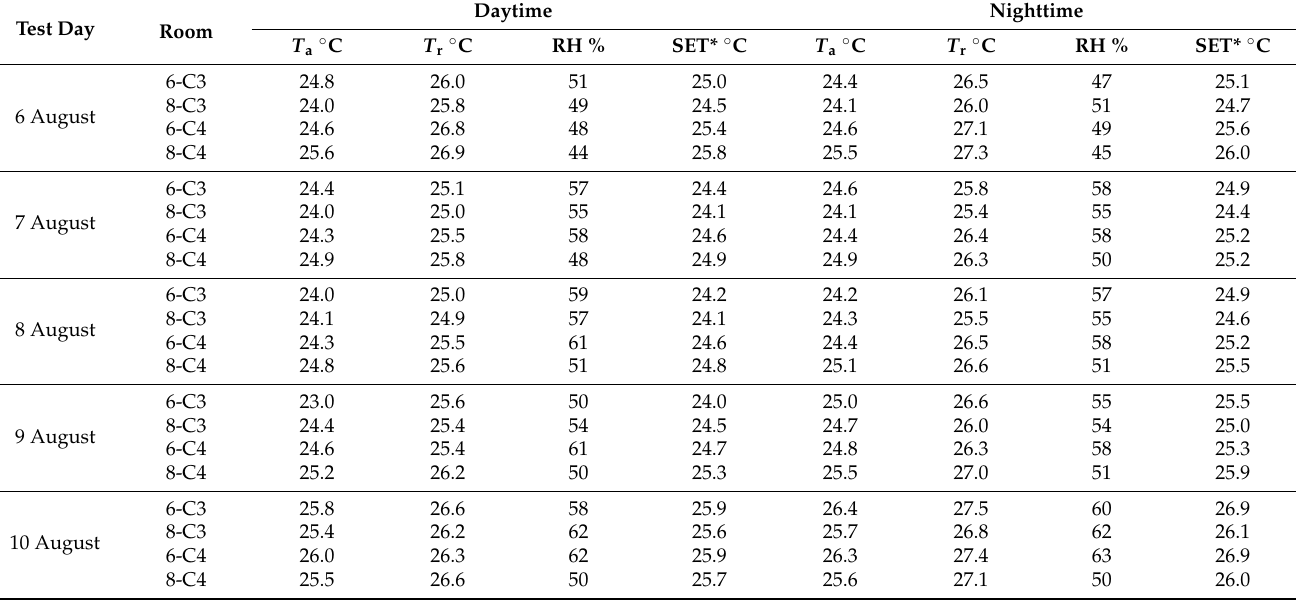
Table 5. Daytime and nighttime SET* of the investigated rooms during the